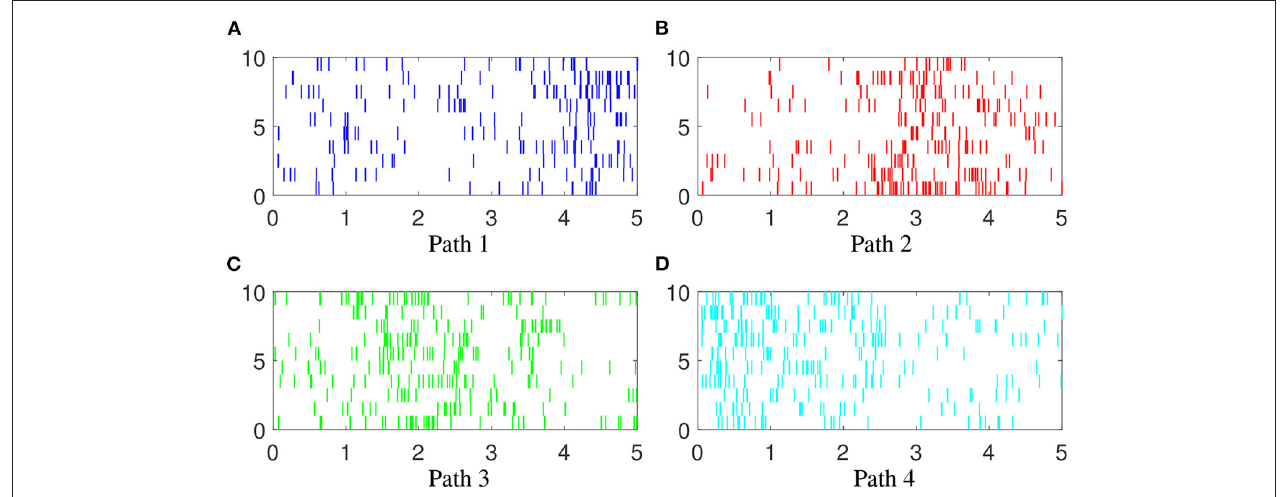
FIGURE 12 | Examples of spike trains. 10 examples of spike trains generated from each path. The four colors (blue, red, green and cyan) indicate spiking activity during hand movement in Paths 1, 2, 3, and 4, (A–D) , respectively. Each vertical line represents one event. Each row represents one trial.